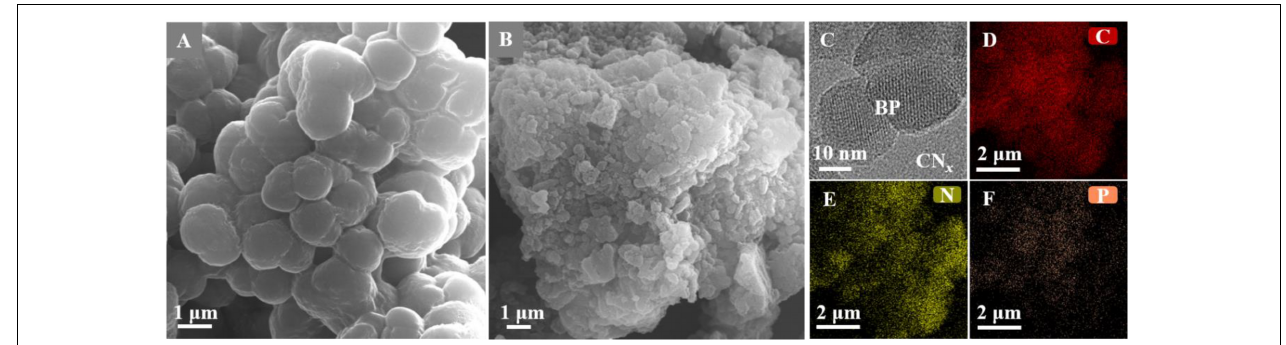
FIGURE 3 | Photoelectrochemical tests of M. barkeri -BPCN x . (A) VB spectrum of M. barkeri -BPCN x . (B) Band gap plot of M. barkeri -BPCN x . (C) I-t curves with a light on/off cycle (20/20 s). (D) EIS Nyquist plots.